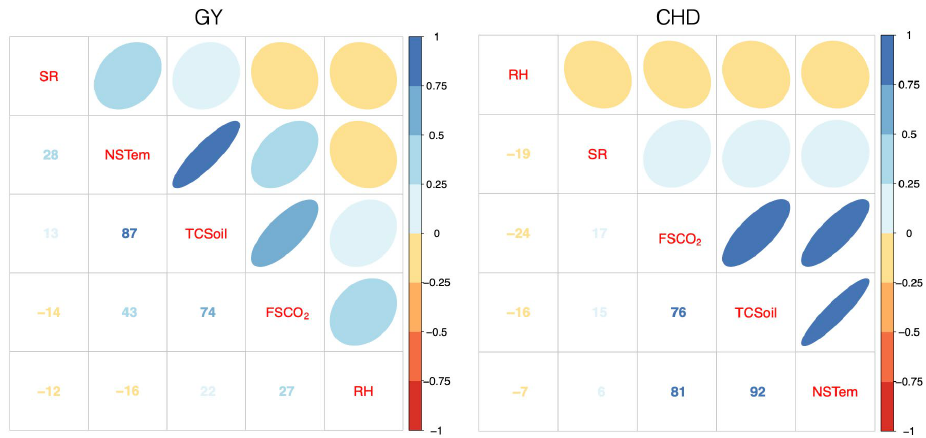
Figure 4. Relationship between the field-measured FSCO 2 and abiotic variables (SR: Soil respiration, TC Soil: Topsoil temperature, TAmbient-Avg: Daily average near-surface temperature, RH: relative humidity) in GY and CHD.